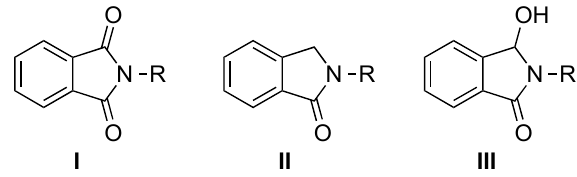
Figure 1. Imide (I), Lactam (II), Hydroxylactam (III).